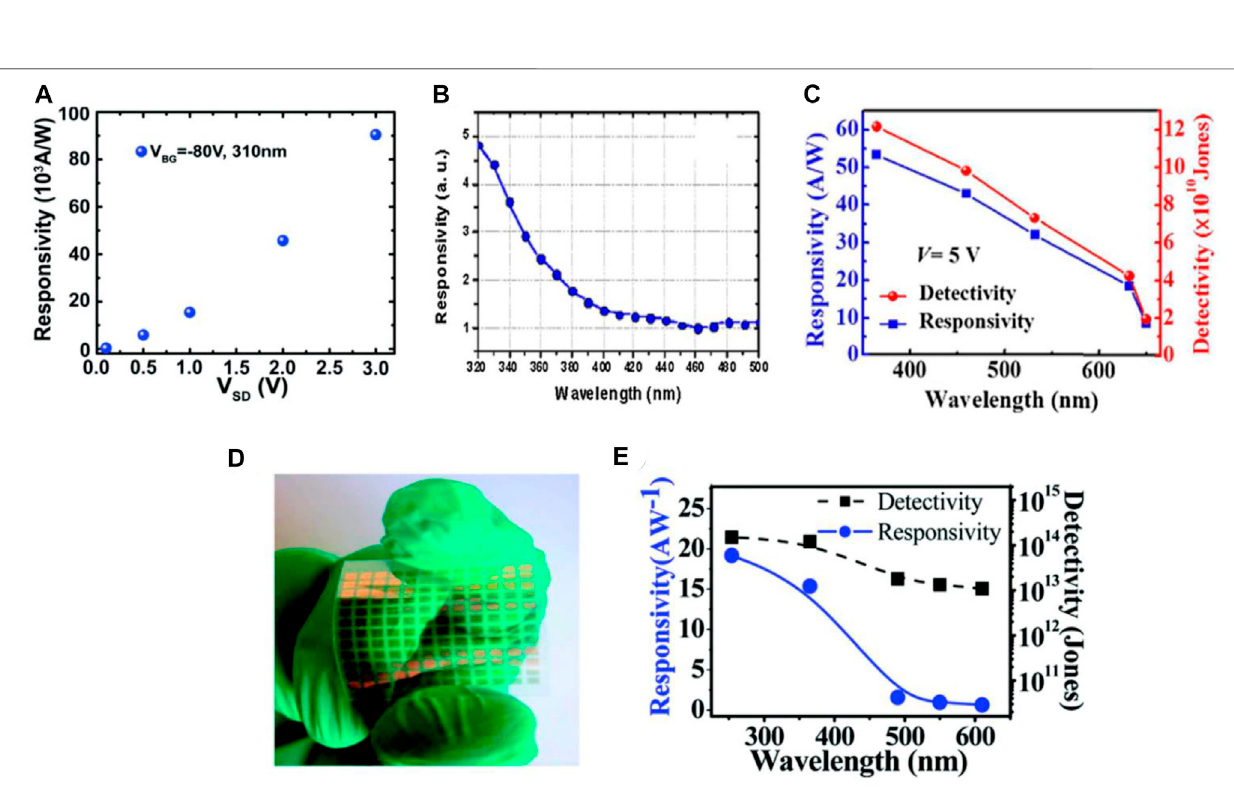
FIGURE 14 | (A) Photoresponsivity of BP based photodetector (Wu et al., 2015), (B) Photoresponsivity of MoS 2 -NCs based photodetector (Alkis et al., 2012), (C) Photoresponsivity and detectivity of WS 2 based photodetector (Zeng et al., 2016), (D) Optical image of GaS thin fi lm-based photodetector (Hu et al., 2013), and (E) Responsivityandphoto-detectivityofGaSthin fi lm-basedphotodetector(Huetal.,2013);Reproducedwithpermissionfrom(Huetal.,2013;Wuetal.,2015;Alkisetal., 2012; Zeng et al.,